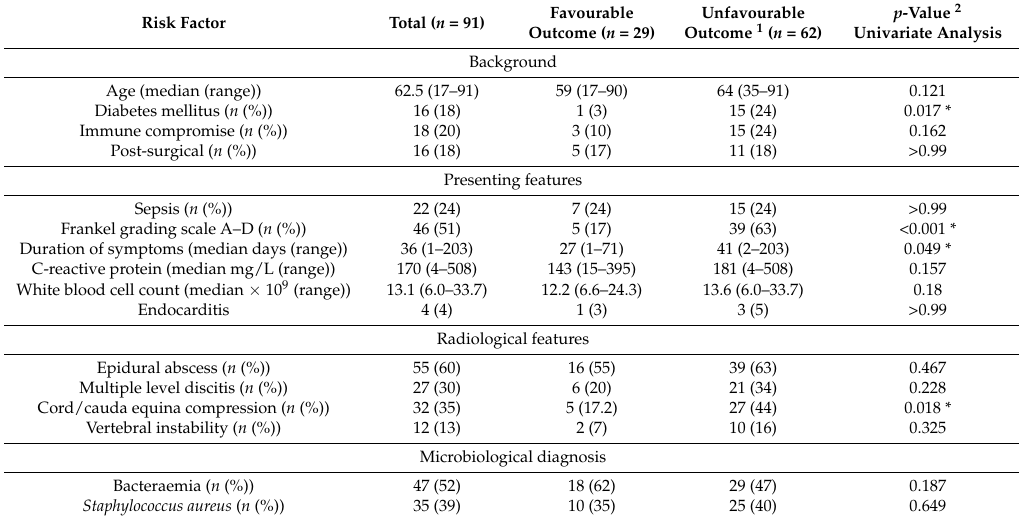
Table 3. Binary logistic regression of factors predicting an unfavourable outcome from spondylodiscitis. Risk Factor Odds Ratio